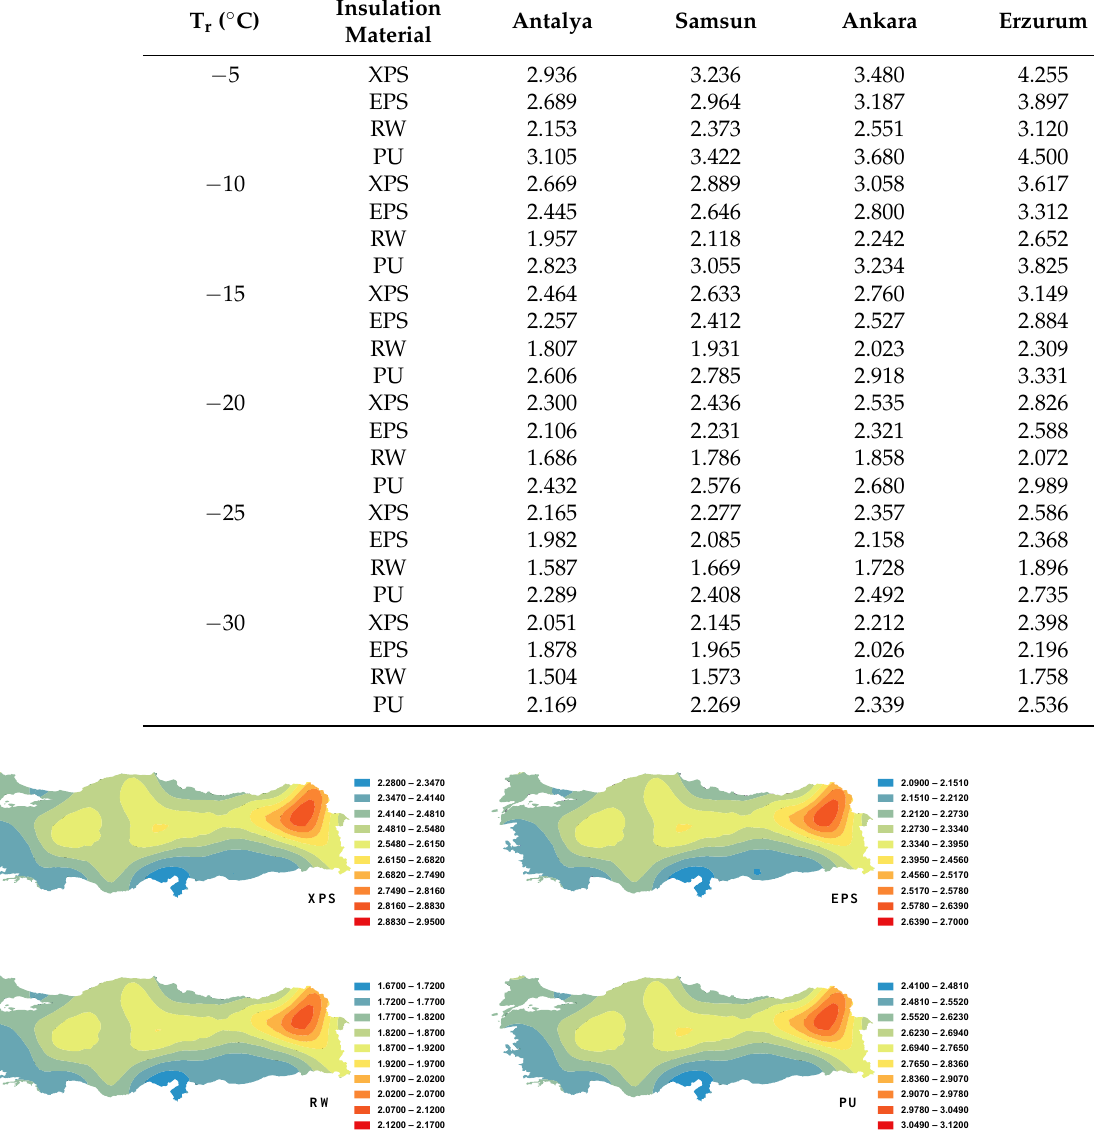
Figure 9. Spatial maps of the payback periods in all climate zones of Türkiye at − 20 ◦ C reference temperature for four insulation materials (each of the maps has its own legend).